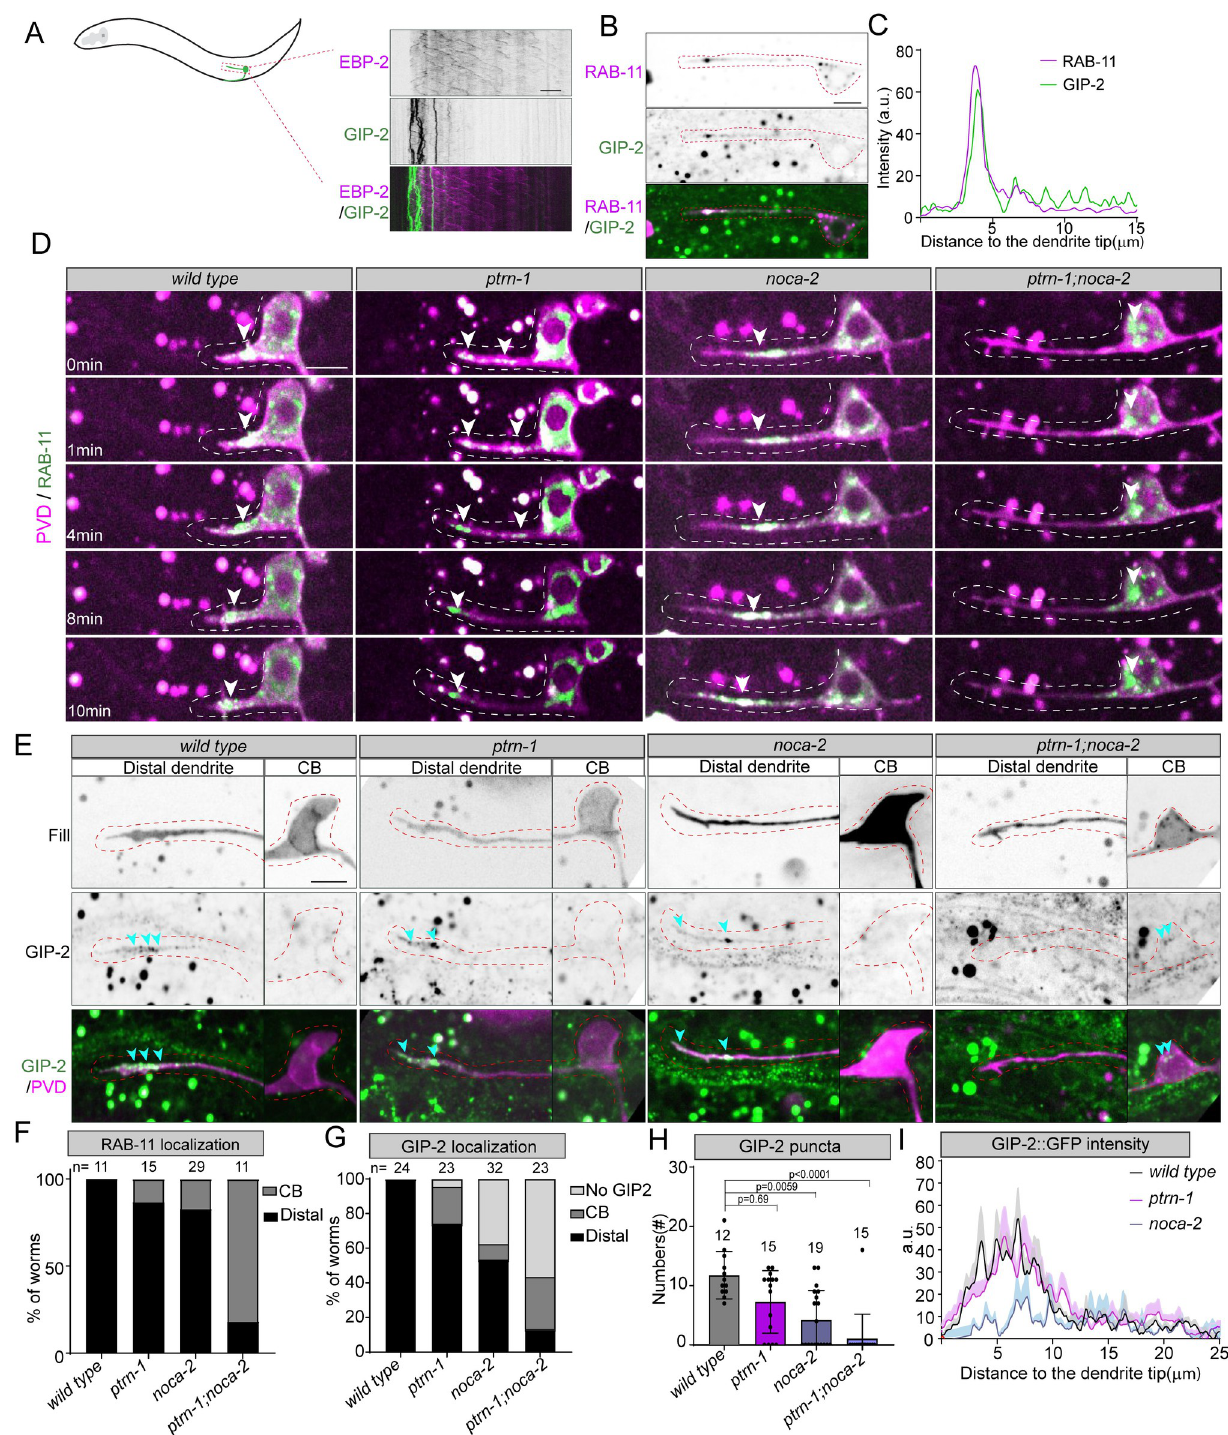
Fig 3. PTRN-1 (CAMSAP) and NOCA-2 (NINEIN) are essential for distal MTOC vesicle localization during neurites outgrowth. ( A ) Kymographs of the growing PVD anterior dendrite expressing EBP-2::mKate2 (PVD specific) and GIP-2::GFP (knock-in). Scale, 5 μ m. ( B , C ) Colocalization of GIP-2:: GFP (knock-in) and mKate2::RAB-11 (PVD expressed) in the distal segment of the growing PVD anterior dendrite. Line scans for intensity profile of each channel from distal dendrites to cell body is shown in ( C ). Scale, 5 μ m. PVD neurons are indicated with red dashed lines in ( B ). ( D ) Vesicle dynamics of PVD neurons expressing GFP::RAB-11 in the distal segment of the growing anterior dendrite in wild-type and indicated mutants. White arrowheads point to the dynamic RAB-11 clusters. Scale, 5 μ m. Dashed line marks the developing dendrite. ( E ) GIP-2::GFP (knock-in) localization in the